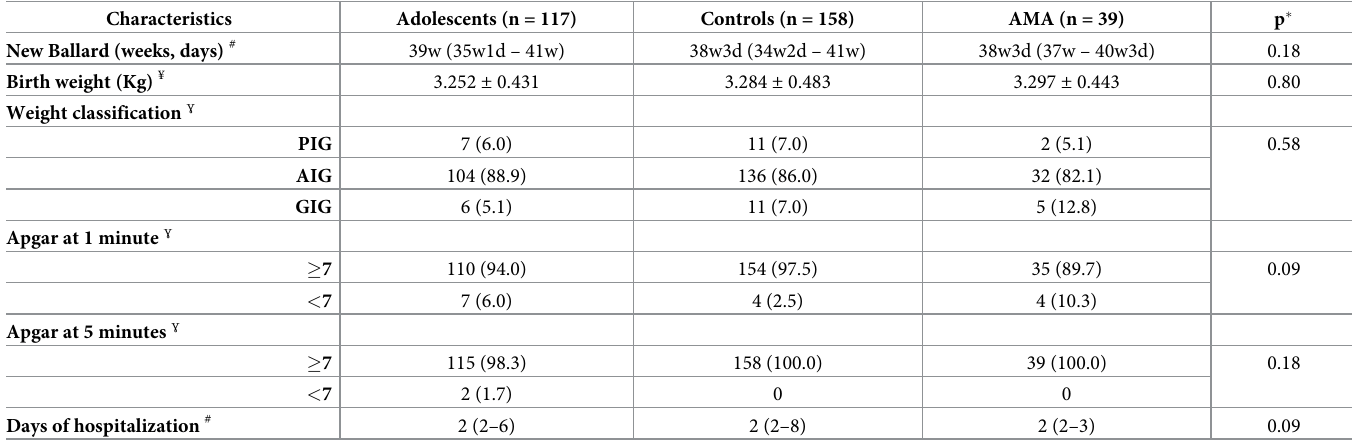
Table 3. Perinatal results of newborns of adolescent, control, and advanced maternal age nursing mothers included in the study. Characteristics